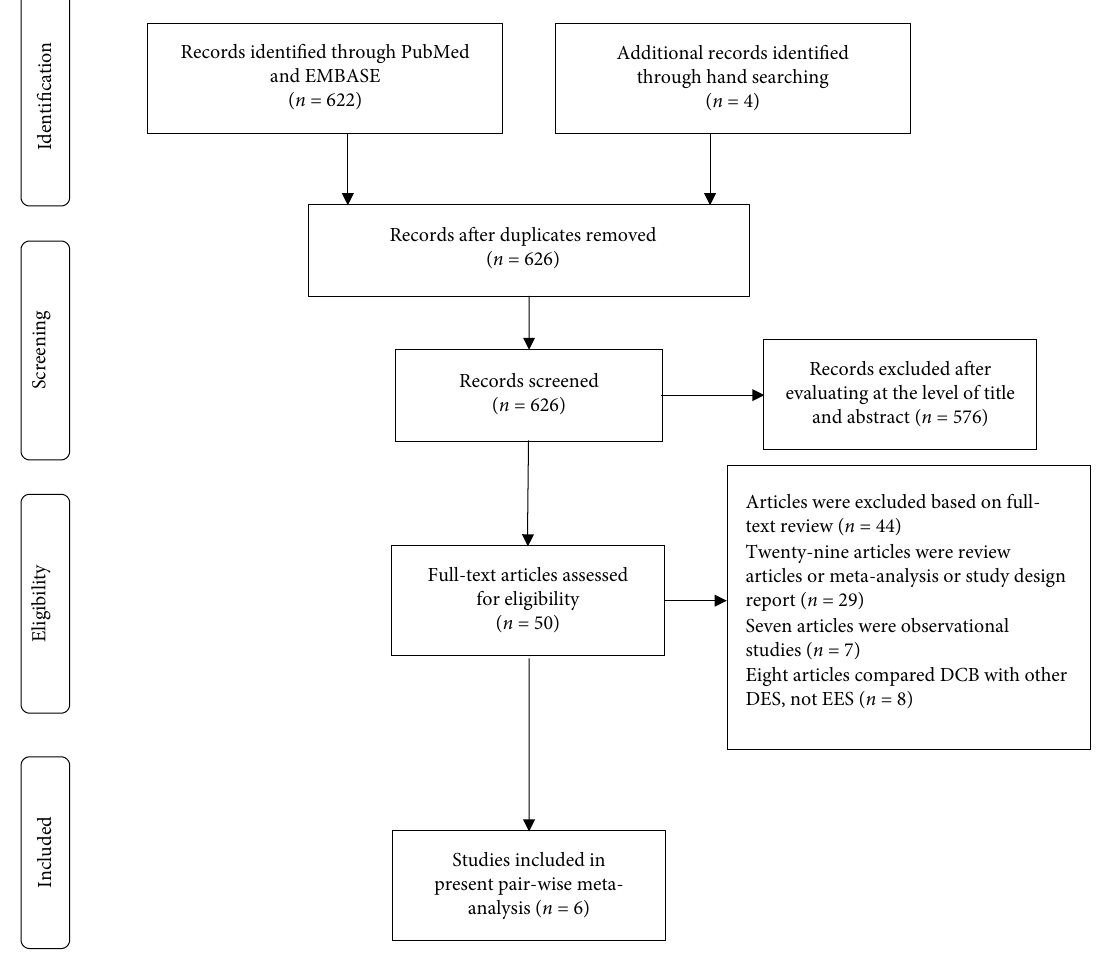
Figure 1: Flow chart of study